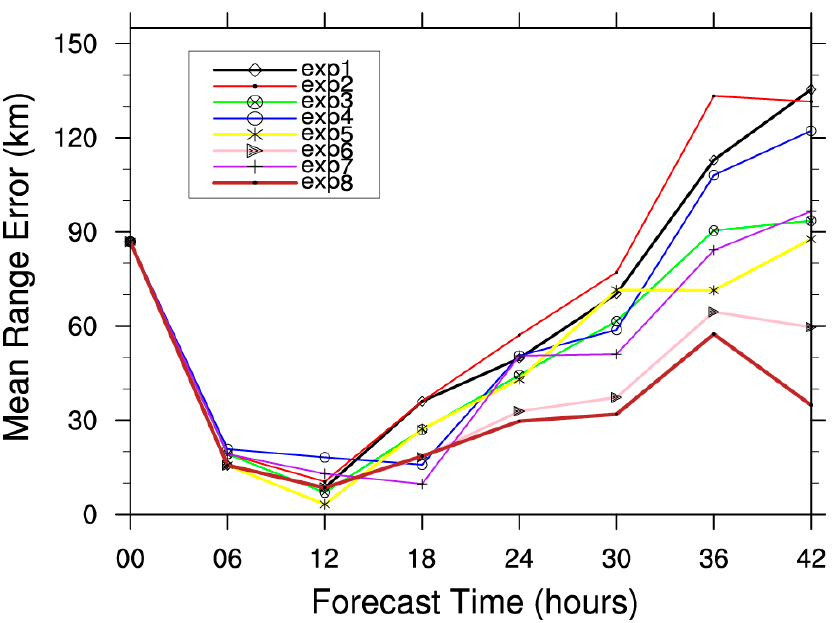
Figure 4. The mean track error (units: km) with forecast leading time for different experiments from 0600 UTC 8 August to 0000 UTC 10 August 2019.